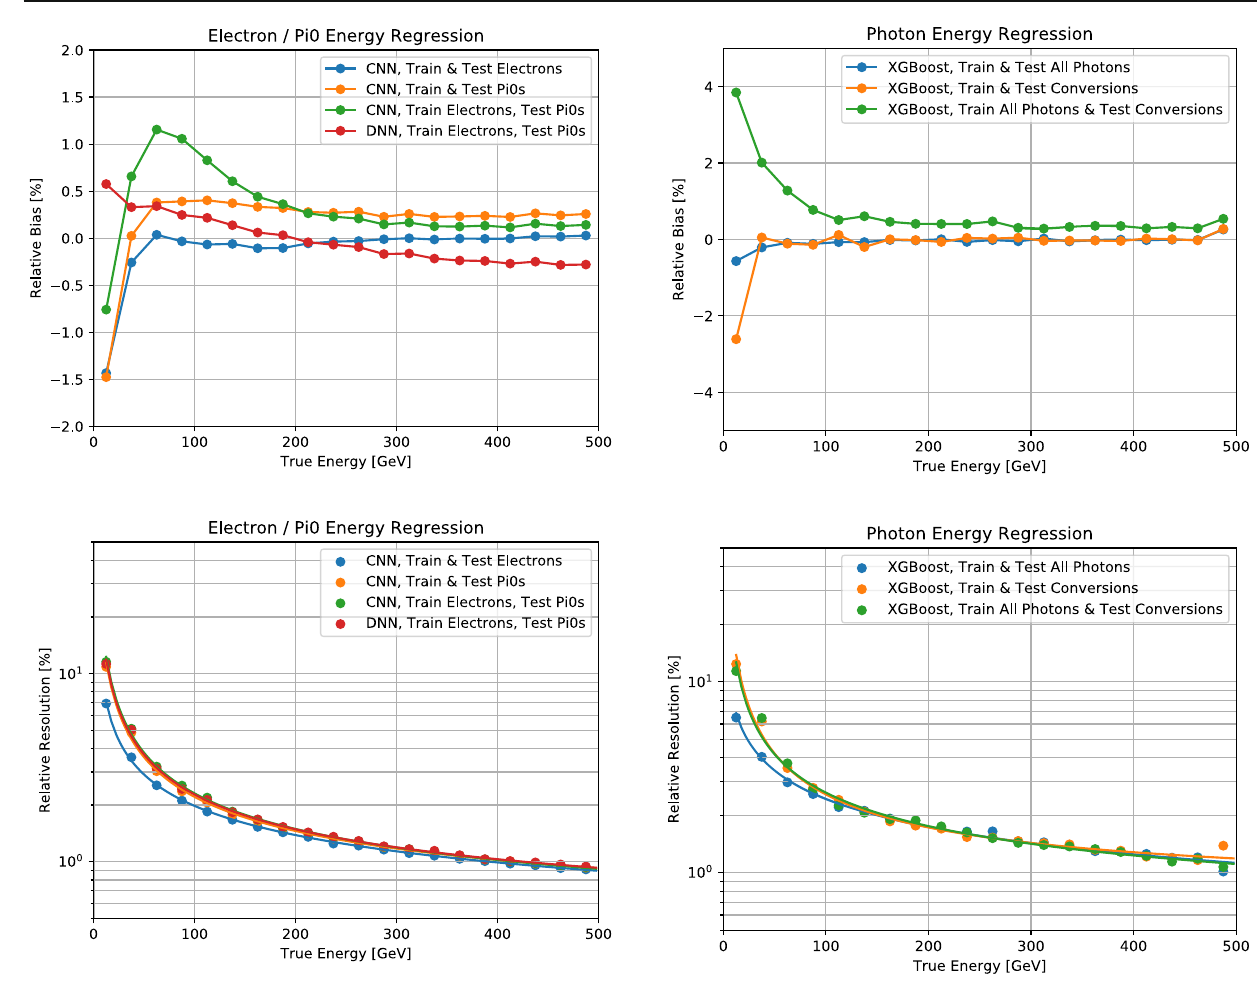
trons forming two showers instead of one in the calorimeter. WithXGBoost,theresolutionremainsthesameforconverted photons when training on the full sample, while for CNN or DNN, the resolution is worse below around 100 GeV. The bias is also worse for converted photons at lower energy when training on all